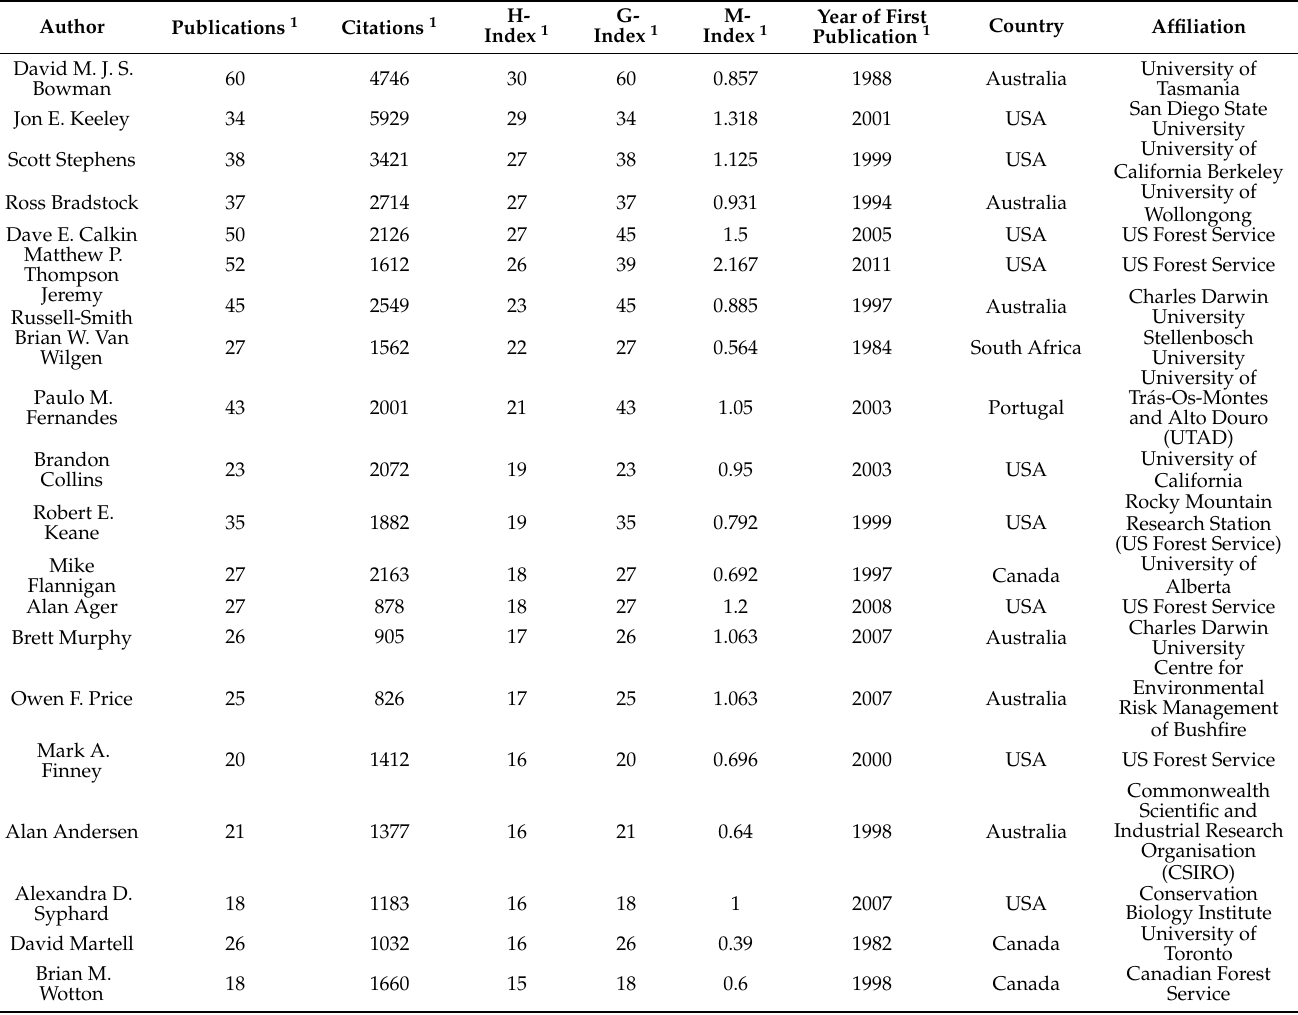
Table 3. Most prominent authors in the field of fire management, listed by h-index